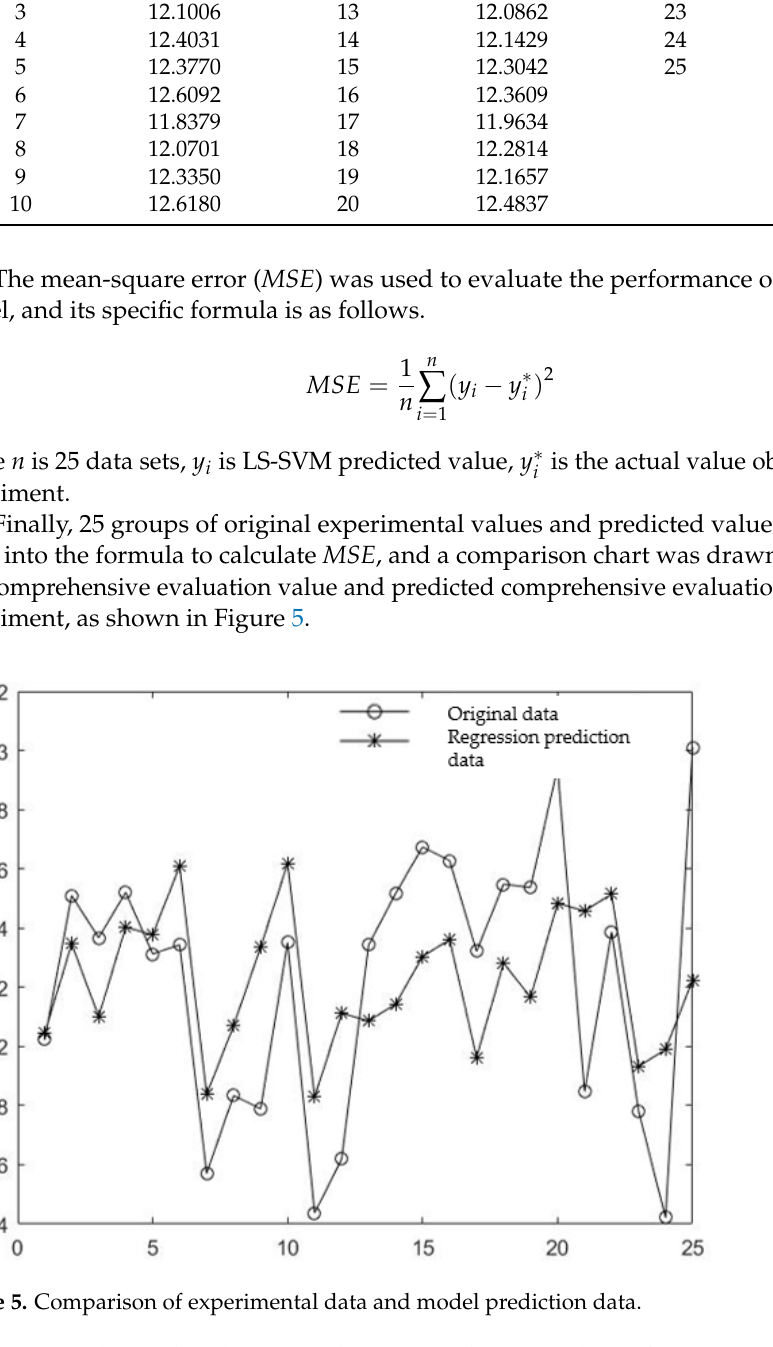
Predicted Value